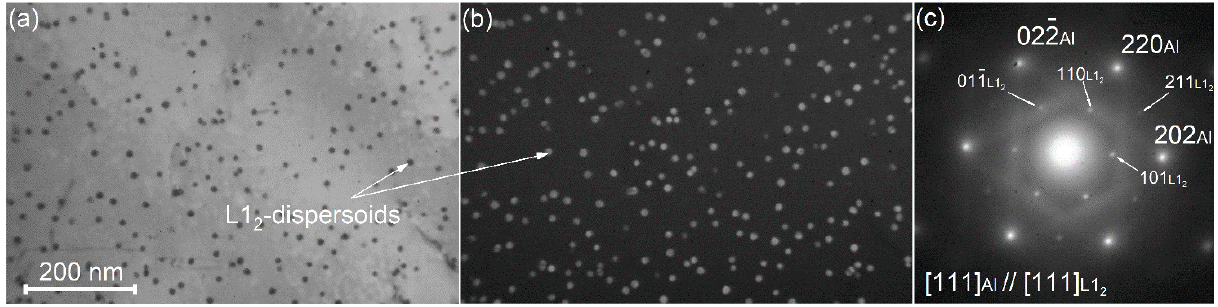
Figure 8. TEM images for the alloy 3 (Al-1.2Mg-0.7Si-1.0Cu-3Ni) after two-step annealing; ( a ) bright field; ( b ) dark field; ( c ) corresponded SAED.